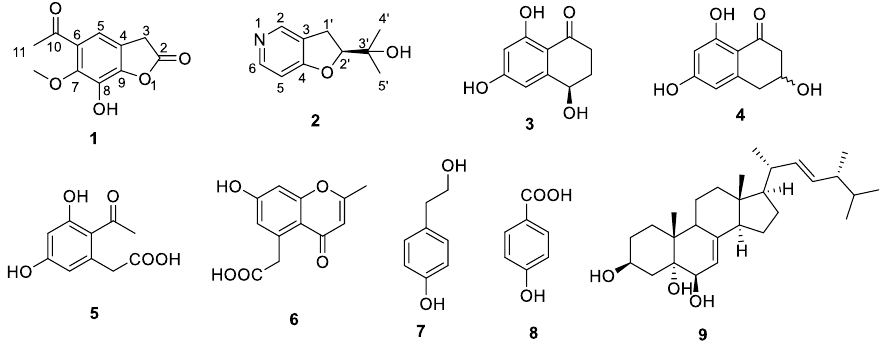
Table 1. 1 H (400 MHz) and 13 C (100 MHz) NMR data for compound 1 (DMSO- d 6 ).